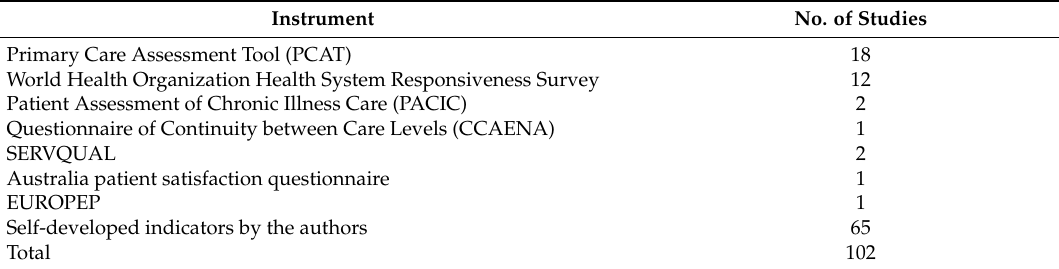
Table 1. Patient experience measurements of primary health care in the 102